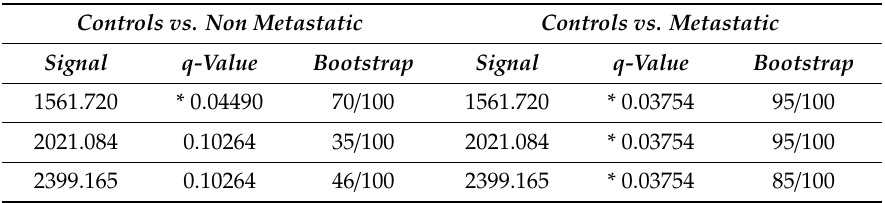
Table 3. Results of the bootstrap analysis.